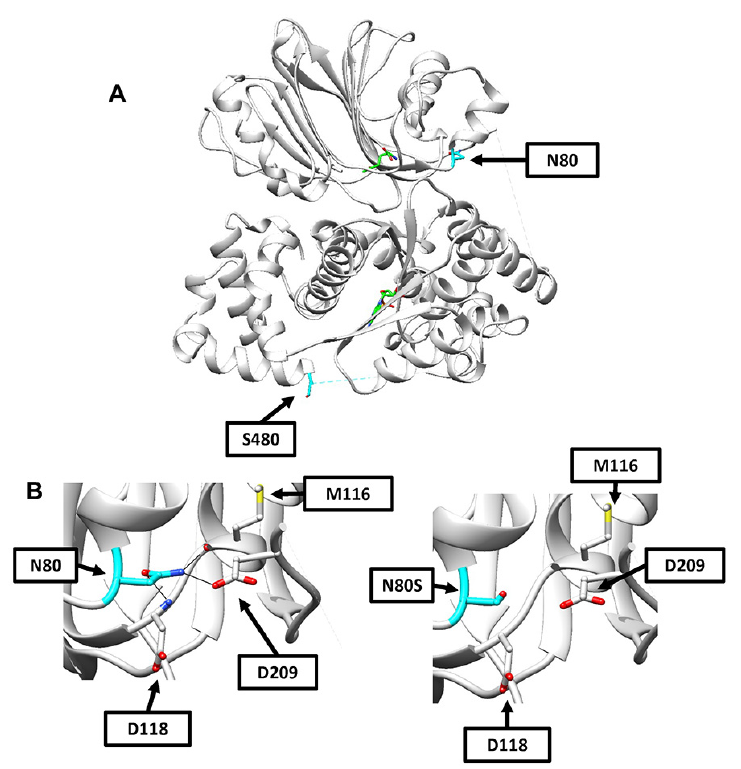
Figure 2. Computational models of N80S and S480F variants. ( A ) A model of the entire human ASNS crystal structure showing the locations of N80 and S480 in cyan. Glutamine is shown in the N-terminal binding site and AMP in the C-terminal binding site, with both backbones in green, nitrogen atoms in blue, oxygen atoms in red, and phosphorous in orange. ( B ) Shown in the ( left ) panel is a close-up of the region containing N80 and showing predicted hydrogen bonding interactions with M116 (2.9 angstroms), D209 (2.9 angstroms), and D118 (2.9 angstroms). Shown in the ( right ) panel is the same region now displayed with the most probable N80S rotamer in place. Increased distances lead to the absence of hydrogen bonding predictions between N80S and M116 (3.9 angstroms), D209 (3.9 angstroms), and D118 (3.6 angstroms).